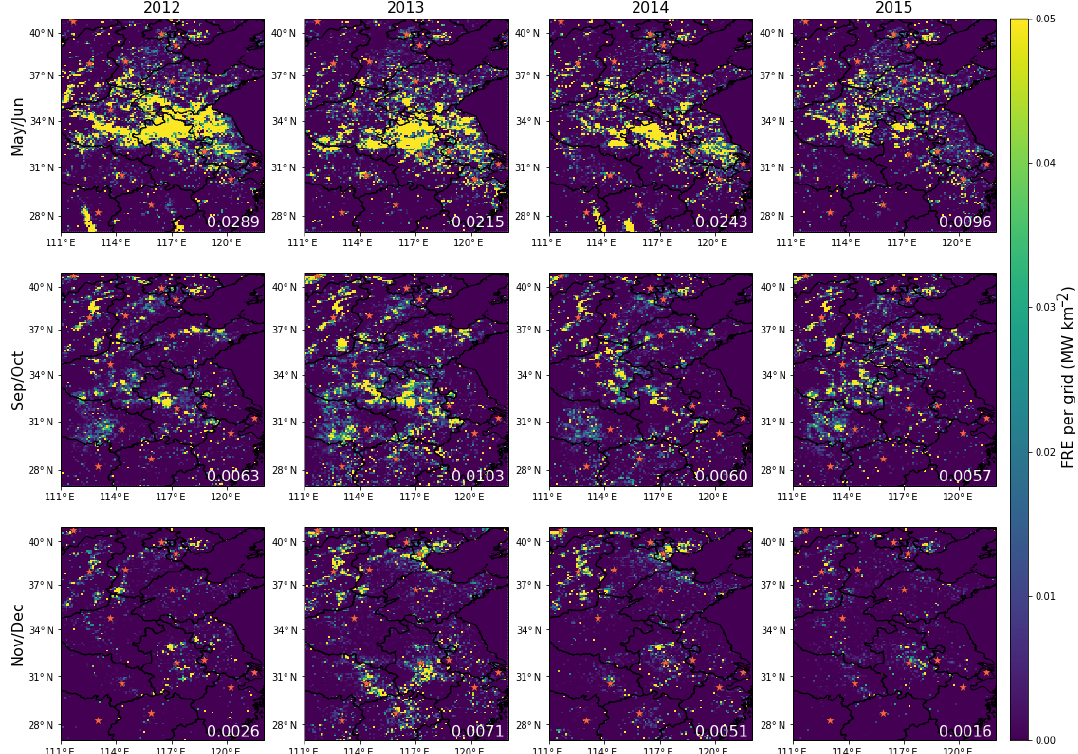
Figure 6. Spatial distribution of FRE areal density (MJm − 2 , 0.1 ◦ grid cells) for agricultural fires in eastern China from 2012 to 2015 (top to bottom rows) split by fire season: summer (May–June, top row), autumn (September–October, middle row), and winter (November– December, bottom row). Mean regional FRE for each season is indicated in white text, and the capital city location of each province is shown as an orange star on each map. The basic layer of country–province borders within this map was created using the Python Cartopy library.